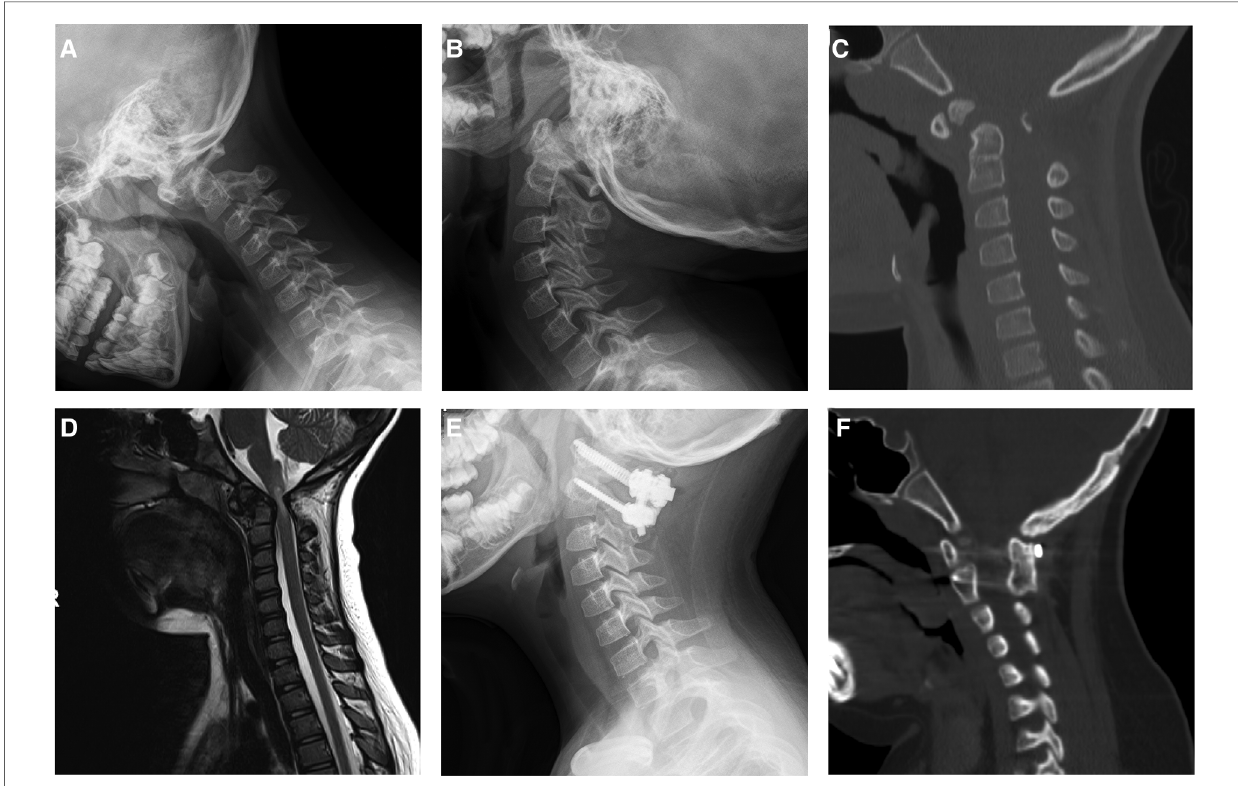
FIGURE 3 Images of a 8-year-old boy with atlantoaxial dislocation due to os odontoideum. This patient underwent atlantoaxial fusion with the use of OBG. Preoperative plain radiograph in fl exion ( A ), extension ( B ) showed atlantoaxial dislocation. CT showed os odontoideum ( C ). MRI showed neural element compression ( D ). Postoperative plain radiograph in neutral ( E ) showed rigid fi xation. Computed tomography sagittal reconstruction showed solid bony fusion 12 months after surgery, white arrow showed occipital bone donor-site ( F